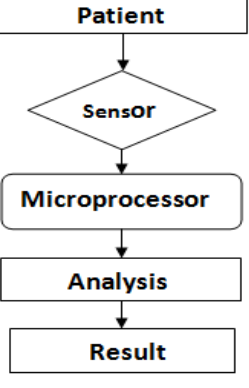
Fig. 3. Working flow of proposed